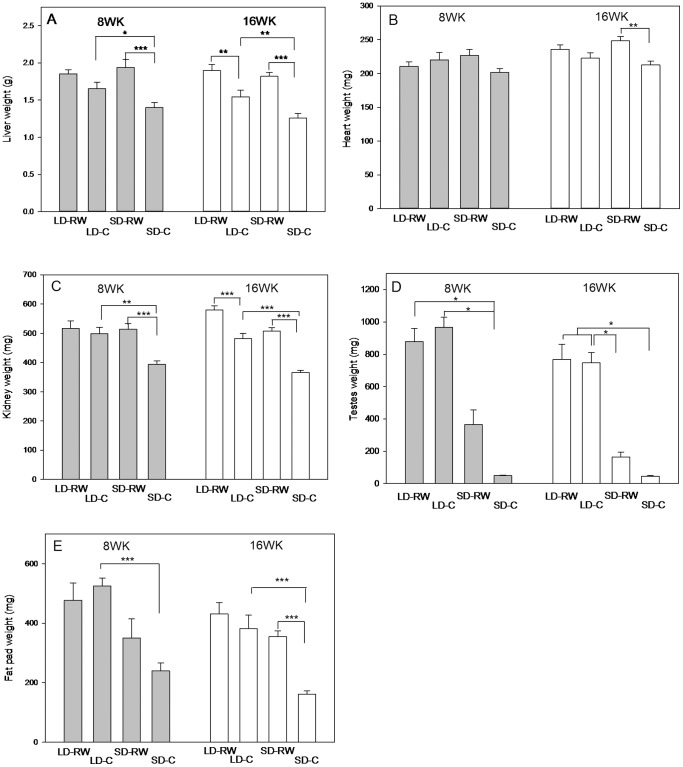
The effect of running wheel activity on organ mass.(A) Liver, (B) heart, (C) kidney, (D) paired testes, (E) right epididymal fat pad of adult male Siberian hamsters after 8 (filled bars) or 16 week (open bars) exposure to long day (LD) or short day (SD) photoperiod with (RW) or without (C) a running wheel (n = 6 per group 8 weeks or 6–9 per group 16 weeks). Relevant significant differences are shown *P<0.05, **P<0.01, ***P<0.001.